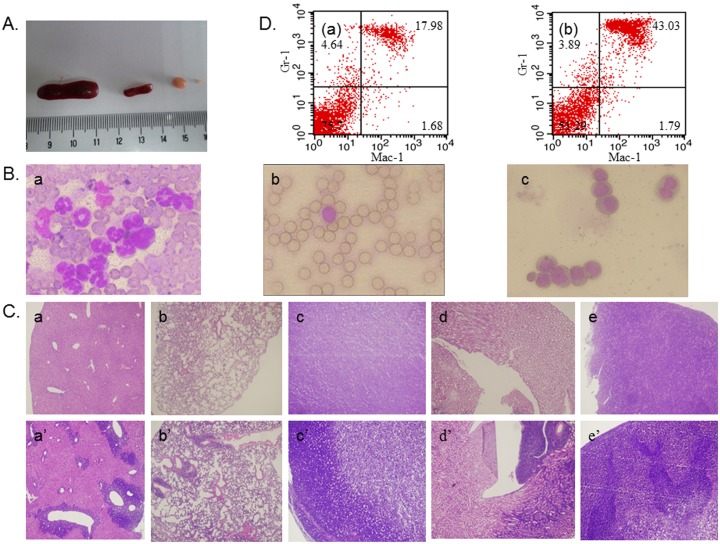
Establishment and characterization of an AML mouse model for evaluating treatment response by transplanting of BXH-2 derived myeloid leukemic cells into syngeneic mice (B6C3F1).Fig. 1A) Gross anatomic examination of spleen and lymph node collected from leukemic (left) or normal (right) mice. Fig. 1B) Morphological examination of peripheral blood smears from (a) recipient mice, (b) normal mice and (c) of B117 cells (Wright-Giemsa staining). Representative fields are shown here. Fig. 1C) Pathologic examination of organ sections, including liver (a & a’), lung (b & b’), lymph node (c & c’), kidney (d & d’), and spleen (e & e’), obtained from normal (a∼e) versus leukemic (a’∼e’) mice (H & E staining). Fig. 1D) Immunophenotypic analysis of bone marrow cells recovered from normal (a) or leukemic (b) mice.